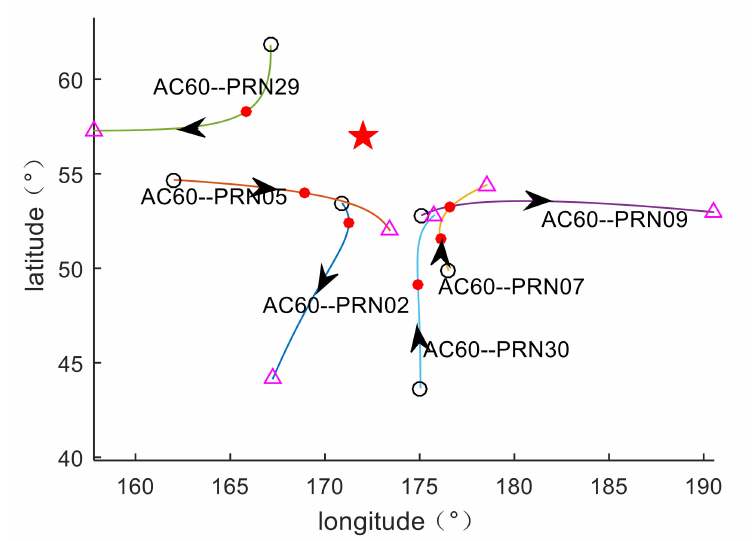
Figure 5. IPP trajectory map. The red pentagram is the position of the explosion point, the black dot is the starting point of the puncture-point track, the triangle is the end point of the puncture-point track, the red dot is the puncture-point position of the meteor explosion, and the arrow indicates the IPP movement